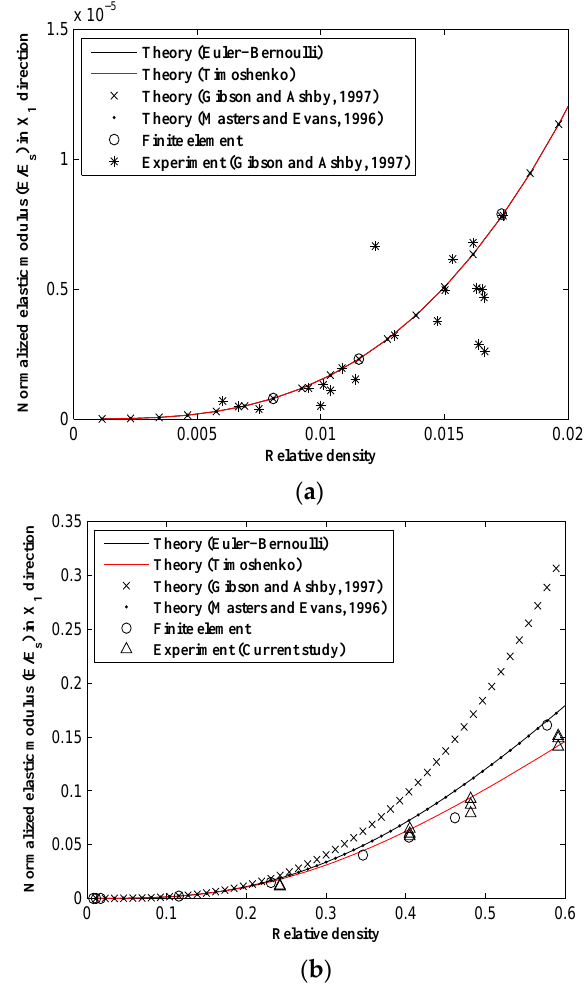
Figure 10. Variation of relative elastic modulus in X 1 direction ( E 1 { E s ) vs. relative density ( ρ { ρ s ) for analytical, experimental, and numerical results. ( a ) For small relative density range; and ( b ) for the complete range of relative density.